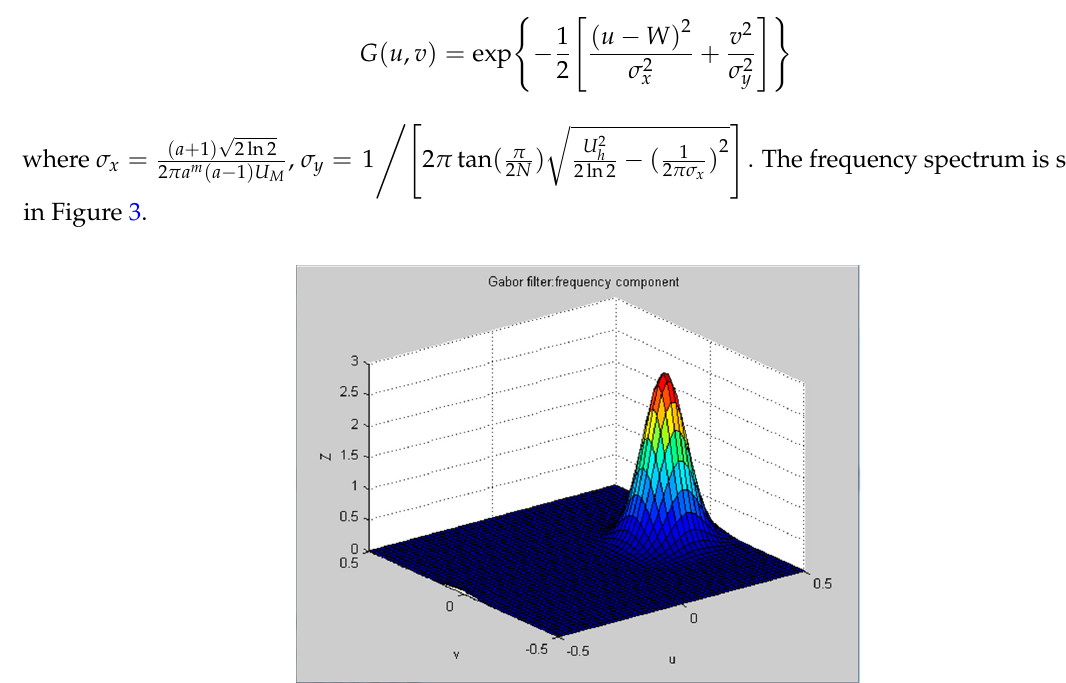
Figure 3. Frequency component of Gabor filter.